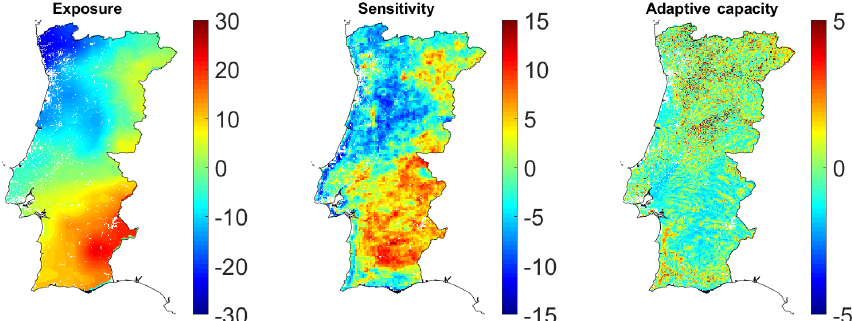
Figure 5. Spatial pattern for the exposure, sensitivity and adaptive-capacity components, as obtained by PCA applied to the indicators presented in Table